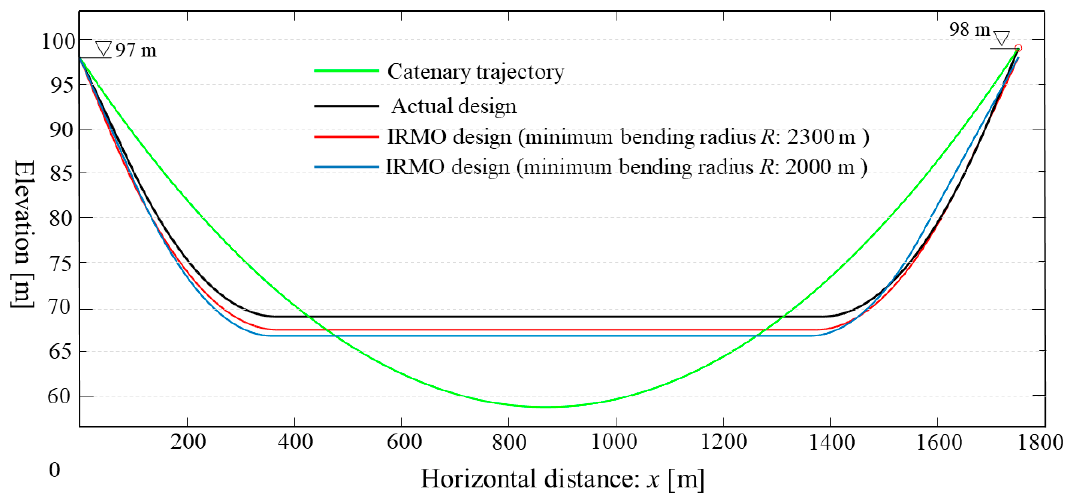
Figure 23. Comparison of IRMO design and actual design. Table 8. Comparison of parameter design results.